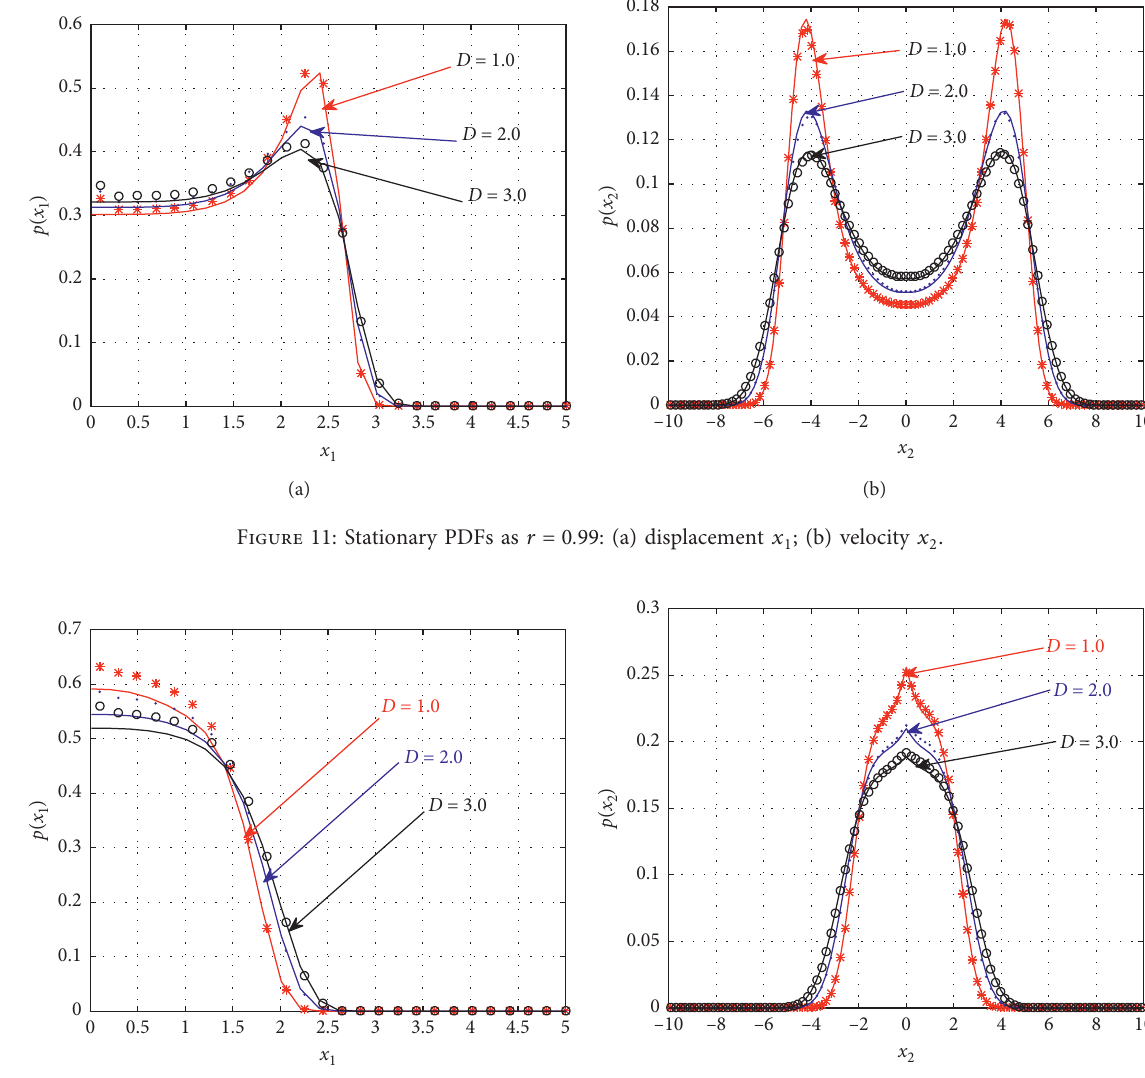
; (b) velocity x 1 2